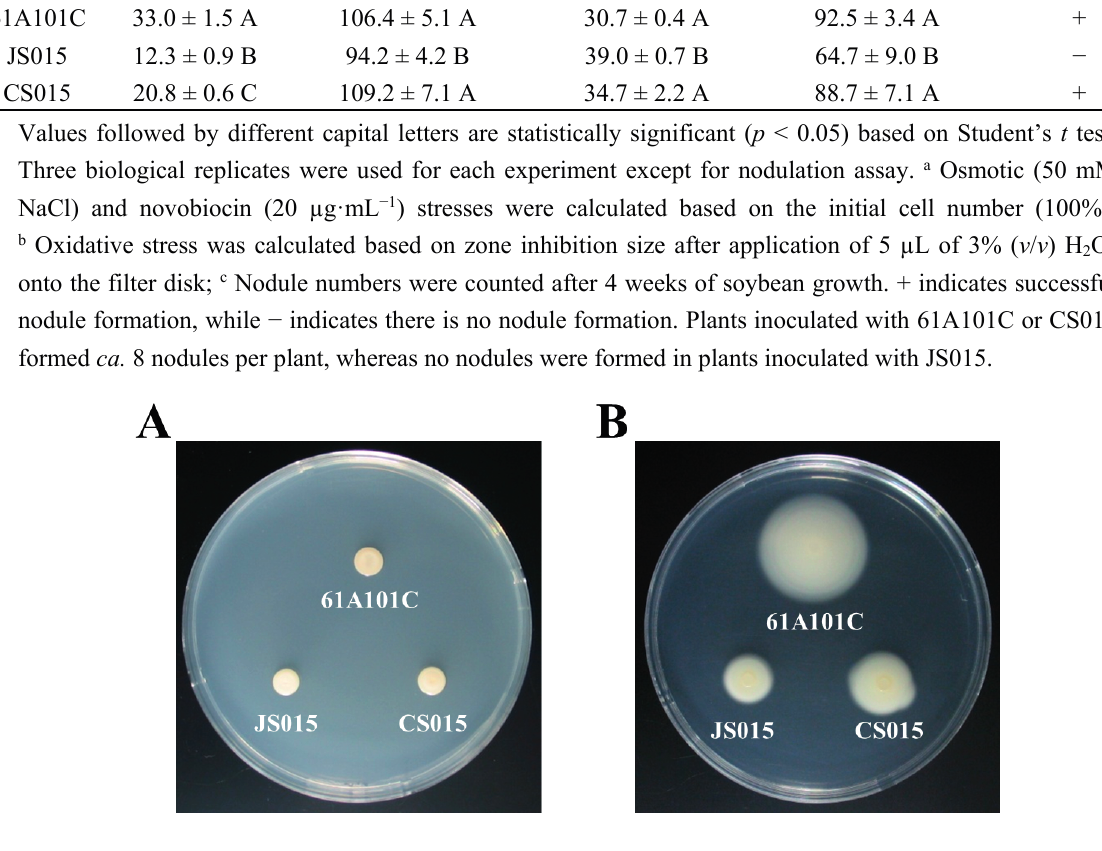
Figure 4. Motility of three B. japonicum strains 61A101C, JS015, and CS015: ( A ) 1% solid agar medium; and ( B ) 0.3% soft agar